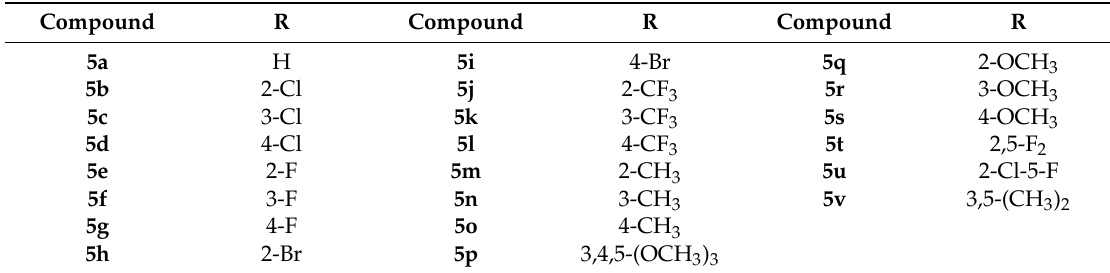
Table 1. The synthetic routine of the title compounds 5a – 5v .